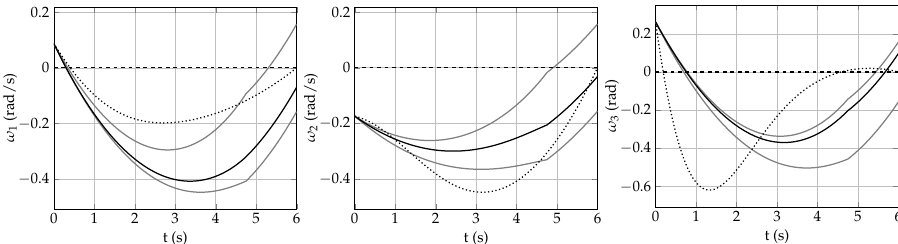
Figure 7. Angular velocity of the spacecraft. The black curves are the angular velocities of the actual nonlinear system, whereas the gray curves are the angular velocities of the auxiliary linear systems. The dashed line is the desired angular velocity and the dotted line a solution using a non-convex